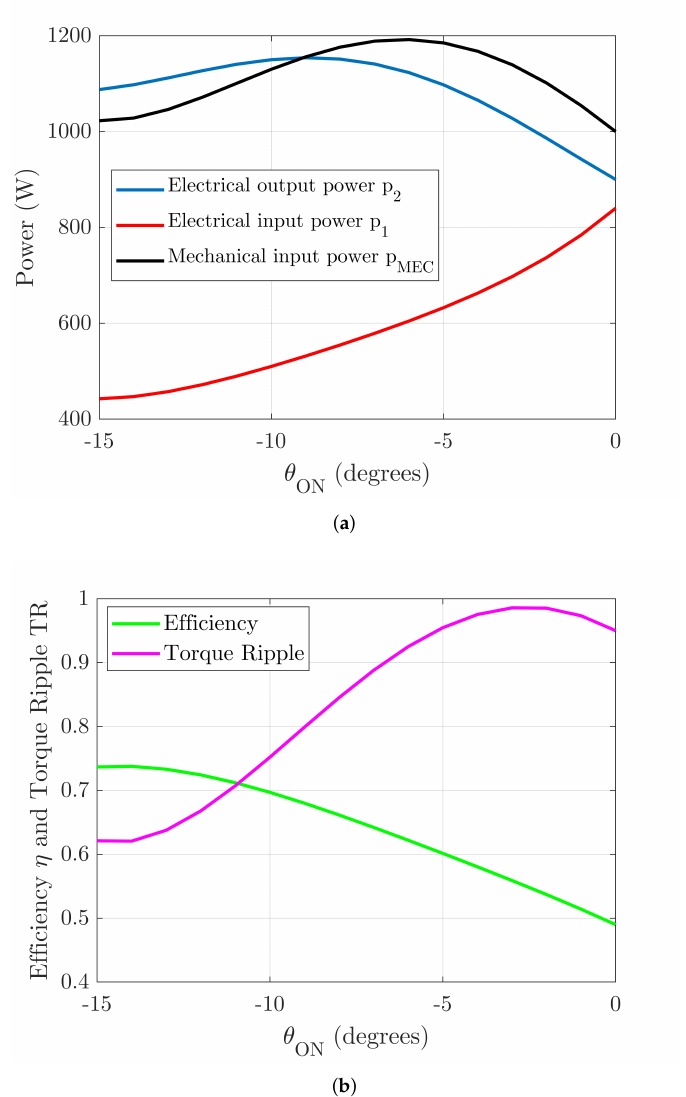
Figure 7. Behavior of SRG performance against the variation of the turn-on angle θ ON : ( a ) SRG input and output powers as a function of θ ON variation, and ( b ) SRG efficiency and torque ripple as a function of θ ON